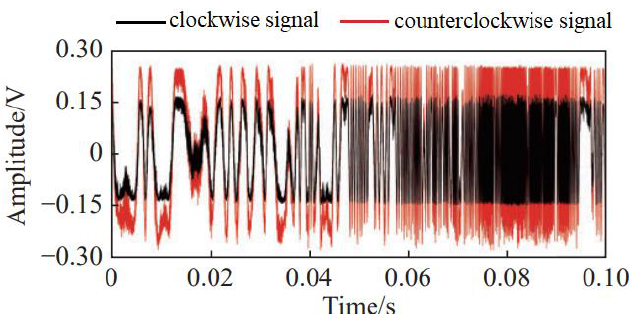
Figure 7. Time domain diagram of interference signal.